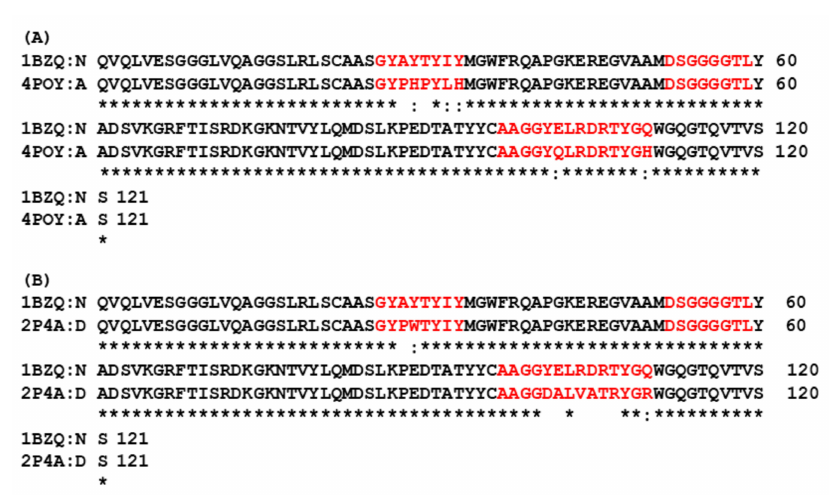
Figure A6. Sequence alignment of V H H complexed with RNase I (PDB ID 1BZQ:N) with templates. ( A ) Alignment with template PDB ID 4POY:A in bestSeqId Temp scenario, and ( B ) alignment with template PDB ID 2P4A:D in bestStructTemp scenario. The highlighted regions in red in each align- ment are the CDRs separating the FRs. The “:” under aligned residues indicate strong similarity in amino acid conservation, “*” indicates identical residues.